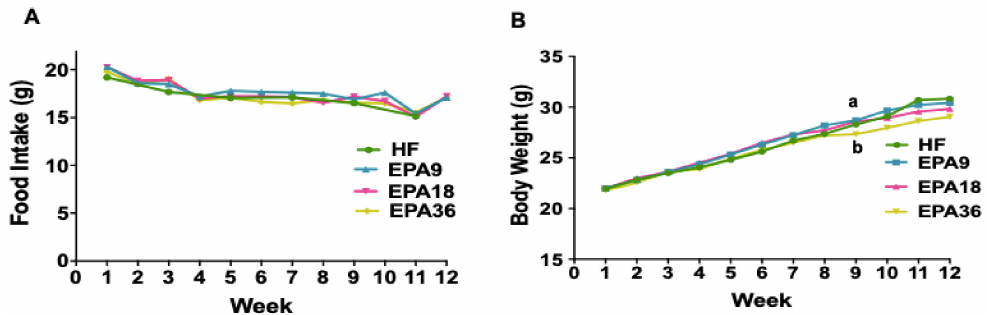
Figure 1. E ff ect of EPA on food intake and body weight among four groups of mice (HF, EPA: 9,18, and 36 g / kg. ( A ) No significant di ff erences in food intake (average per week per mouse) among four group of diets, ( B ) EPA36 significantly reduced body weight after the ninth week compared to HF. Data are expressed as mean ± SEM. Groups represented with same letter indicate no di ff erence. p < 0.05; n = 15 mice per group. EPA, eicosapentaenoic acid; HF, high fat.